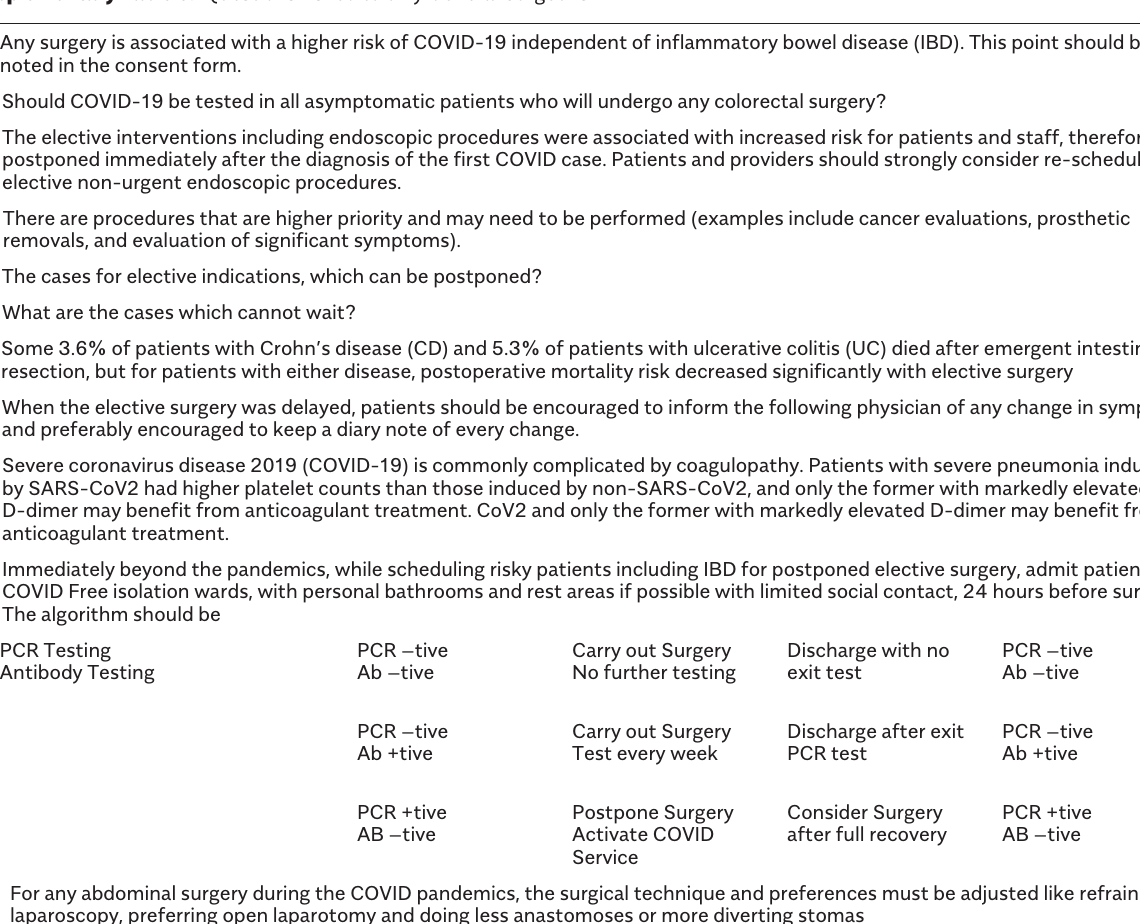
Supplementary Table 3. Questions Asked to only General Surgeons